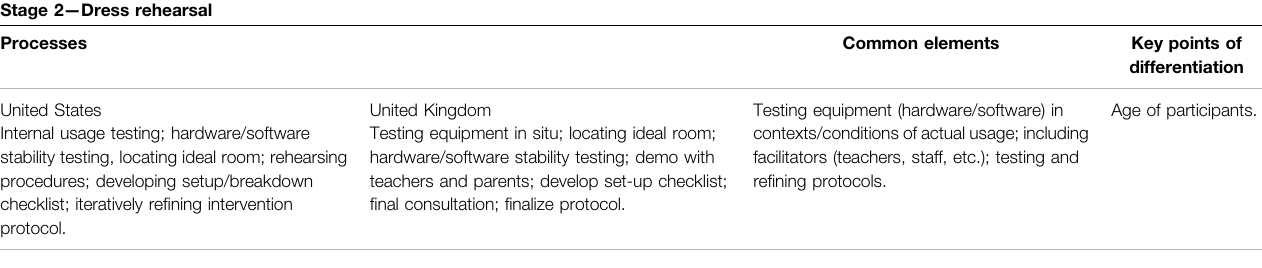
TABLE 5 | Results from thematic analysis: Stage 2 Dress Rehearsal. Stage 2 — Dress rehearsal